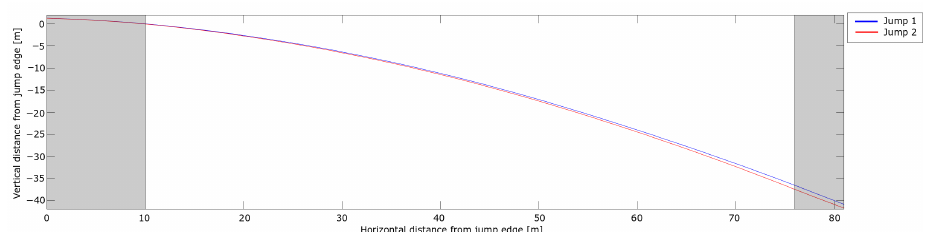
Figure 13. Trajectory from the dGNSS in the flight phase for the two jumps. The gray shaded areas highlight the take-off and landing phases. The horizontal and vertical distances from the in-run edge are shown on the x-axis and y-axis,